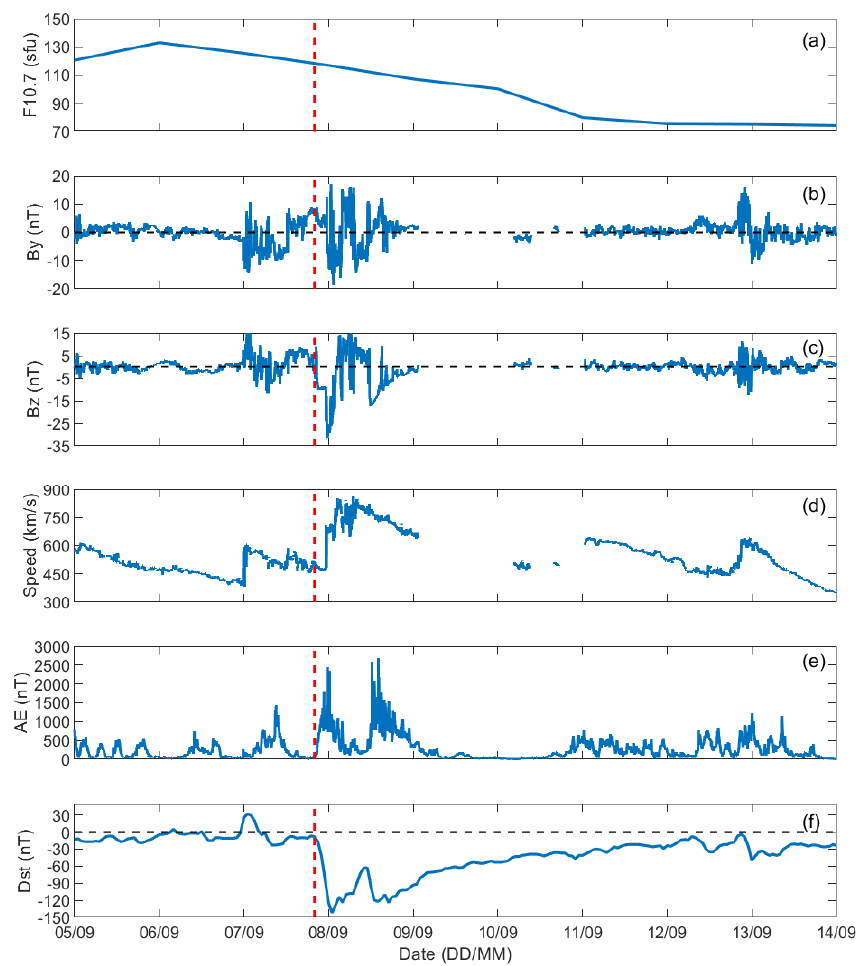
Figure 1. Solar radiation, and interplanetary and geomagnetic parameters, for the period of 05–13 September 2017: ( a ) F 10.7 index, ( b ) IMF B y , ( c ) IMF B z , ( d ) solar wind speed, ( e ) AE index, and ( f ) Dst index. A geomagnetic storm commenced at 20 UT on 7 September 2017. The red vertical dotted line in each panel indicates the first main phase onset time of this storm, and the black horizontal dashed lines in ( b , c , f ) mark the zero values for B y , B z , and Dst ,